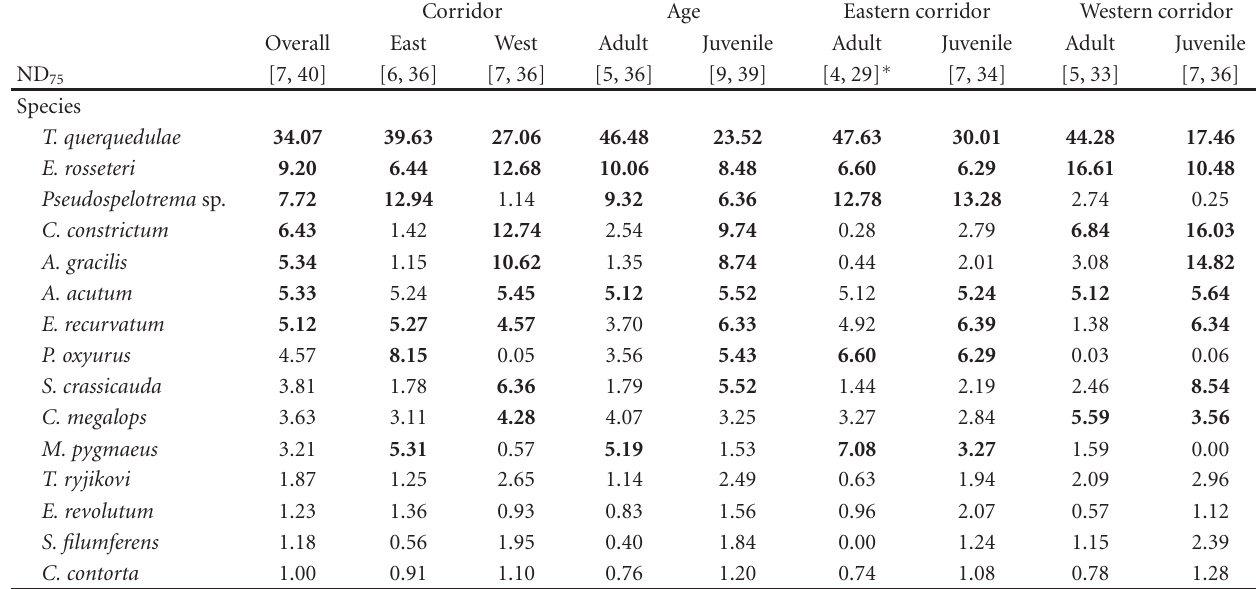
Table 4: Numerical dominance values of species accounting for < 1% of all helminths, and ND 75 values, for the overall helminth community of blue-winged teal ( Anas discors ) and those delineated by host migratory corridor, age, and age within each migratory corridor.